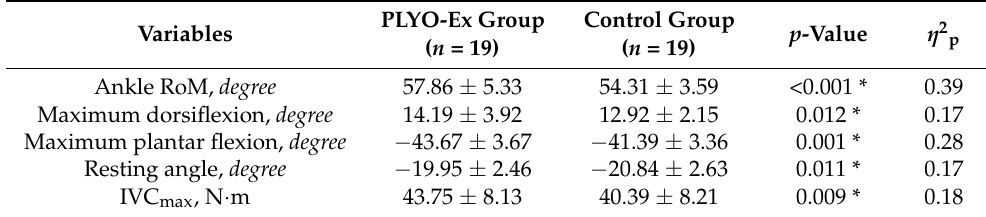
Table 4. Post-treatment differences in ankle RoM and IVC max between the PLYO-Ex and control group. PLYO-Ex Group Control Group Variables ( n = 19)